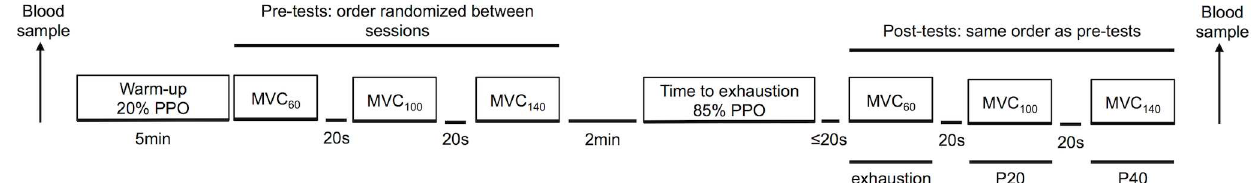
Fig 1. An overview of the study protocol. Angular velocity of the pre and post isokinetic maximal voluntary contraction (MVC) of the knee extensors (KE) tests were randomized between sessions (60-100-140 deg/s, 100-140-60 deg/s or 140-60-100deg/s). One isometric MVC of the knee flexors was also performed pre and post exercise, 20 s followingcompletion of the last KE MVC. Post tests were performed either shortly after exhaustion (13 ± 4 s), 20 s followingexhaustion(P20) or 40 s